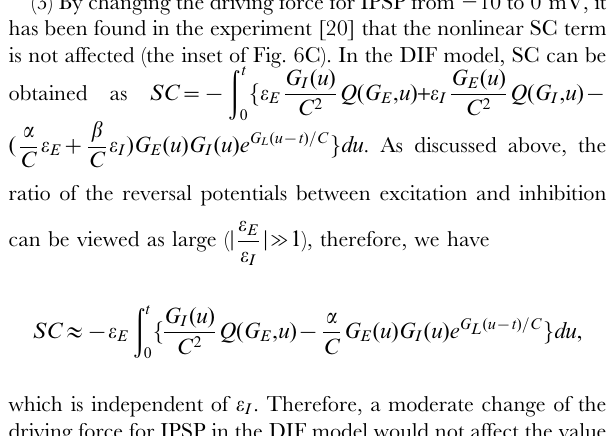
Figure 6. Comparison of DIF model with experiments (A–C), multiple inputs (D), Predictions (E), spatial dependence of k in the I&F model (F). (A) SSP (measured sum) vs. the linear sum between EPSP and direct somatic hyperpolarization. Here, SC is not observed. The inhibition is caused by direct injection of an inhibitory current with amplitude of 2 2.6 mV (red circle online) and of 2 1.3 mV (red square online). Inset: experimental measurement (modified from Ref. [20]). (B) SC vs. the relative time delay between IPSP and EPSP. For fixed inhibitory input site, we choose two different input sites for excitation: one corresponds to the distal dendrite (red circle online) and the other the proximal dendrite (blue square online). Inset: experimental measurement (modified from Ref. [20]). (C) SC is not affected by changing the driving force (DF) of IPSP from 0 to 2 10 mV. Inset: experimental measurement (modified from Ref. [20]). (D) Dendritic integration rule for two excitatory and two inhibitory inputs. The simulated E–I sum represents the SSP obtained from Eq. (12) with a coincident activation of all excitatory and inhibitory inputs, whereas the predicted E–I sum represents the somatic membrane potential obtained from Eq. (11). (E) Comparison between k M and k (cid:2) as a function of time. The remainder term is defined as k M { k (cid:2) (thick gray, blue online). Inset: The asymptotic behavior * t { 1 (denoted by ‘‘asymptotic’’, thick dark dash line, red online) of the remainder term (denoted by ‘‘exact’’, thick gray, blue online) obtained from Eq. (9). (F) spatial dependence of k (cid:2) in the I&F model when the inhibitory input site is fixed. Using the spatial dependence of the conductance time constants, we can obtain the result that k (cid:2) decreases as the distance increases between the excitatory input site and the soma. This is not consistent with the experimental observation (Inset: the same as the inset of Fig. 2).